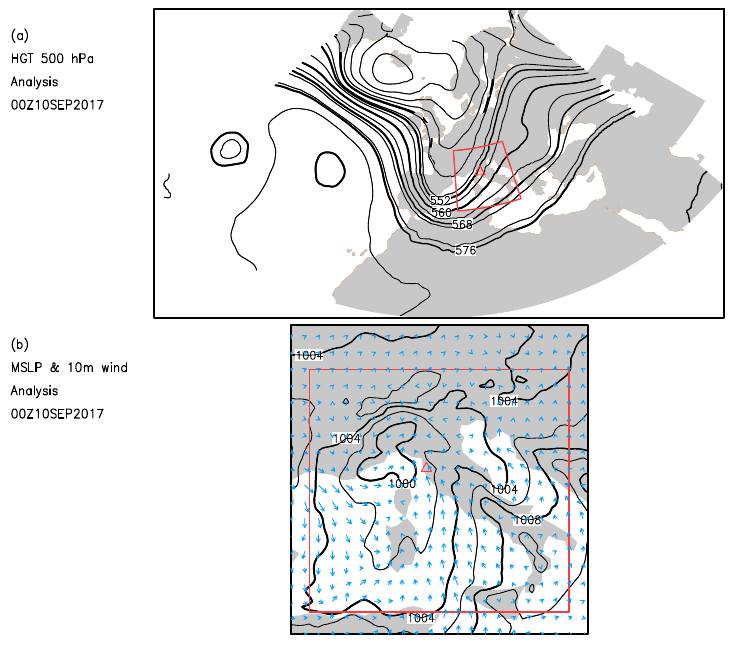
Figure 1. ( a ) Geopotential height at 500 hPa, isobaric level in decametres at 0000 UTC, 10 September 2017. ( b ) Mean sea level pressure in hPa, and 10 m wind vectors in blue at the same time. In both panels, the red rectangle indicates the WRF domain of integration, and the red triangle (“ (cid:52) ”) indicates the location of Livorno. ERA5 data [53] were used to plot the